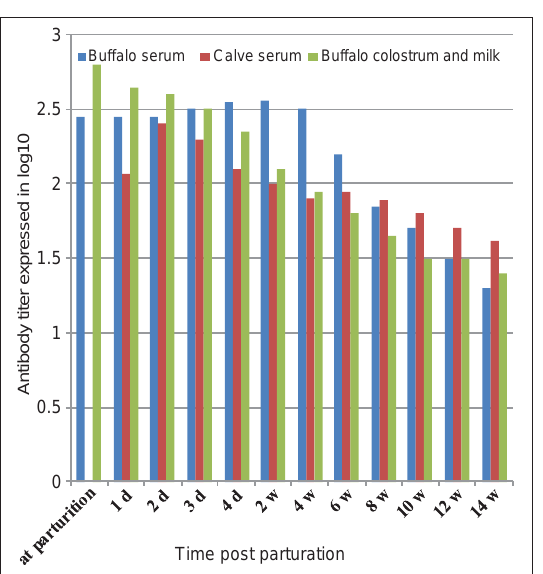
Figure 6: Comparison between the mean antibody titer of serum and colostrum of vaccinated buffalo, their calves by serum neutralization test.